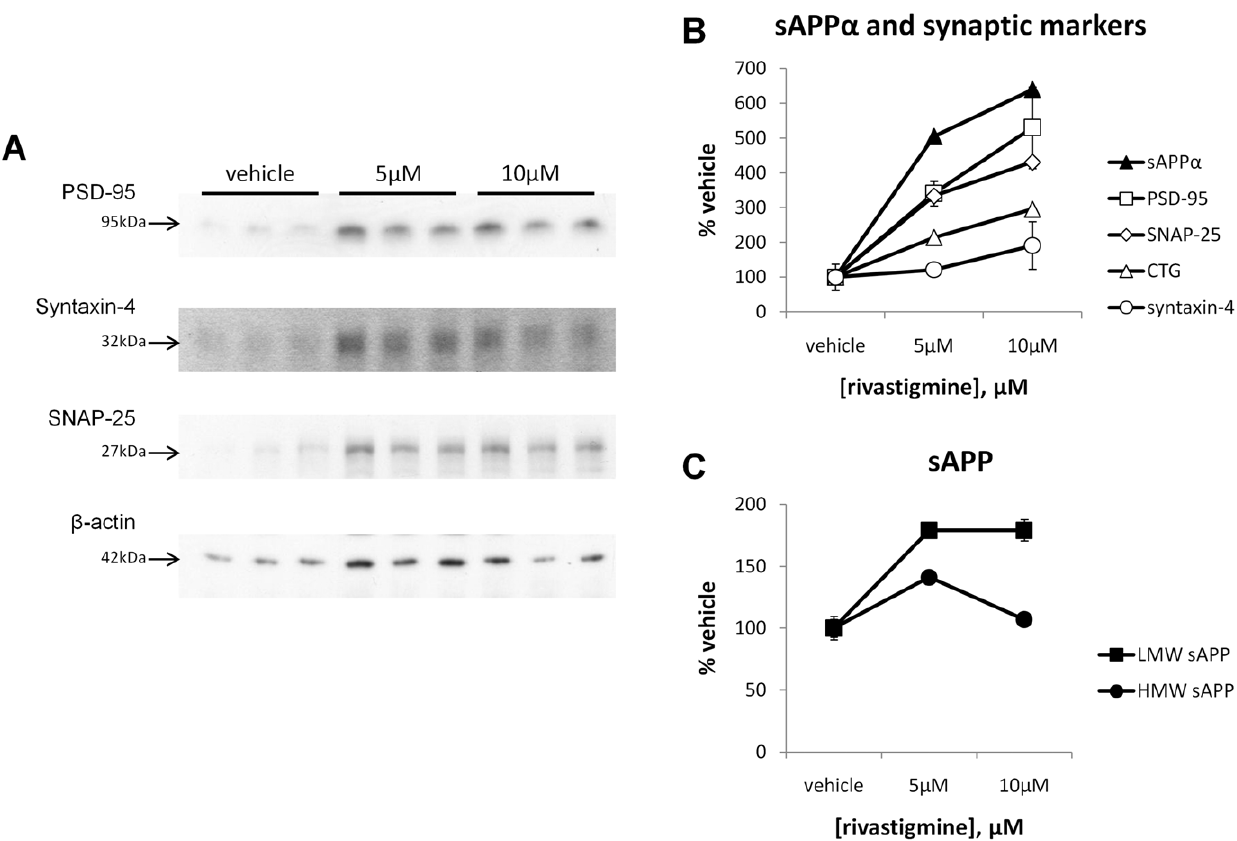
Figure 7. Rivastigmine-mediated increase in neuron-associated sAPP and sAPP a parallels increases in neuronal protein markers. Levels of low molecular weight neuronal sAPP (LMW-sAPP), high molecular weight glial sAPP (HMW-sAPP), and sAPP a were compared to levels of the presynaptic protein markers SNAP-25 and syntaxin-4, and the postsynaptic protein marker PSD-95. All values are expressed as a % of vehicle-treated cells for comparison. PSD-95 and SNAP-25 levels increased dose-dependently with rivastigmine treatment (both p , 0.05), and syntaxin-4 levels increased but this change did not reach significance (7A and 7B). LMW-sAPP was increased with 5 m M rivastigmine but plateaued at the higher concentration. HMW-sAPP increased to a lesser extent at 5 m M, but was similar to vehicle at the higher concentration (7C). These data suggest that increased neuronal and decreased glial sAPP may be involved in the enhanced neuronal and synaptic marker stability that results from rivastigmine treatment, and that modulation of a -secretase may be involved in these